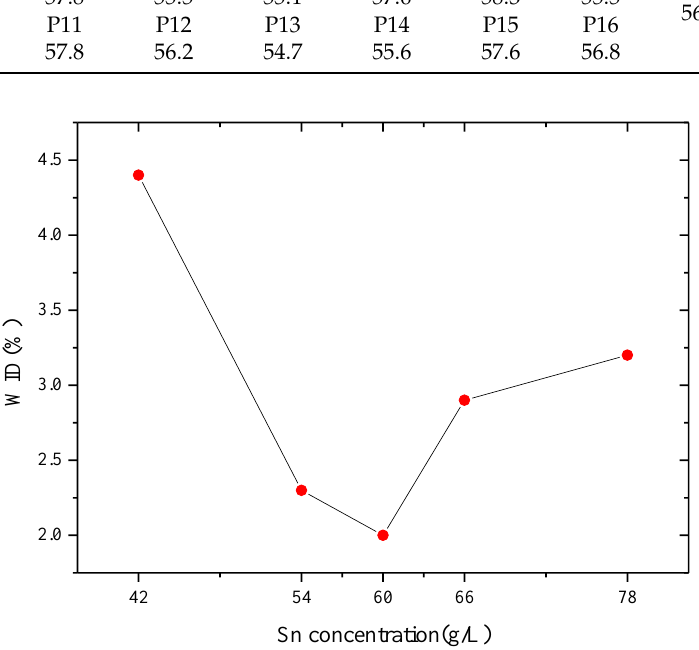
Figure 2. Height deviation of bump according to Sn concentration, WID.